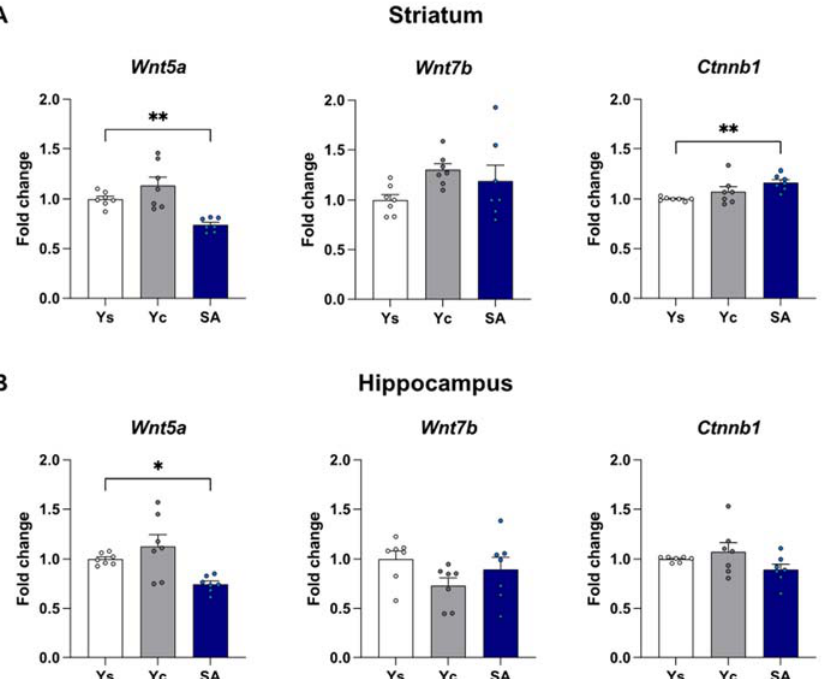
Figure 2. The mRNA expression levels of Wnt5a, Wnt7b , and Ctnnb1 in the striatum ( A ) and hippocampus ( B ) after 14 days of cocaine self-administration (0.5 mg/kg/inf.). n = 7 rats/group. Significance was determined using a one-way ANOVA and the post hoc Dunnett’s test. * p < 0.05, ** p < 0.01 versus the yoked saline (Ys) control group. SA: cocaine self-administration group; Yc: yoked cocaine group.